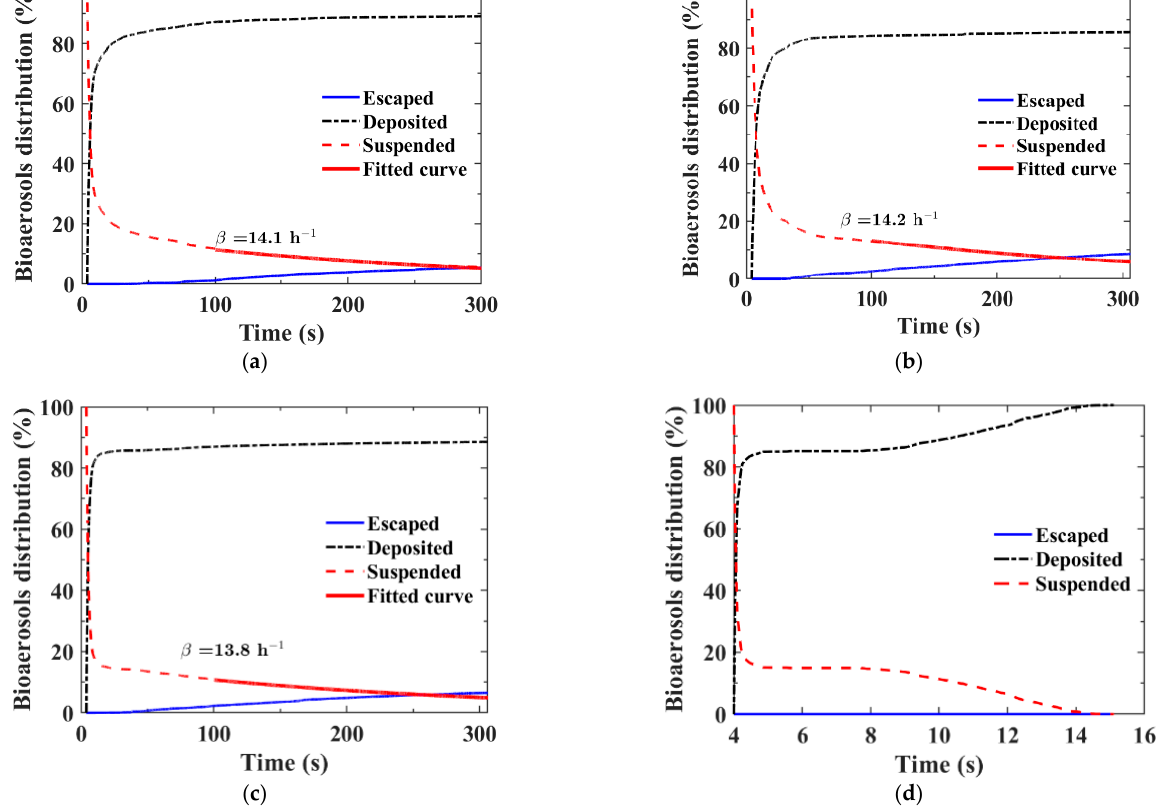
Figure 8. States of bioaerosols, and the empirical exponential fit to the number of suspended bioaerosols for Case 1 by size: ( a ) 1 µm; ( b ) 5 µm; ( c ) 10 µm; ( d ) 50 µm.